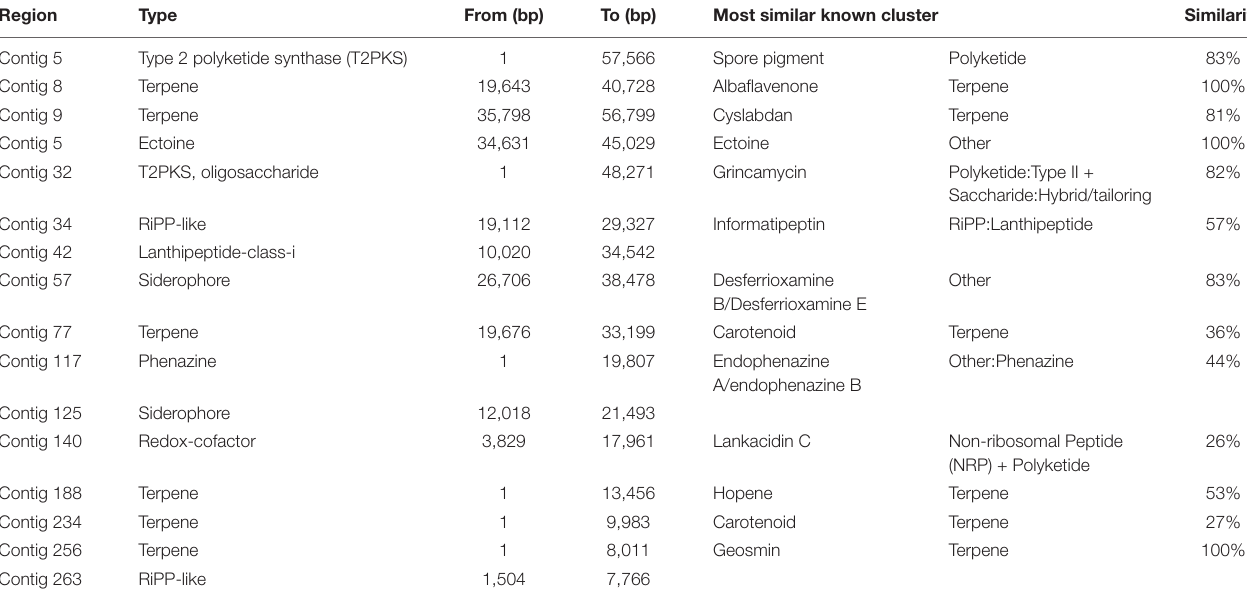
TABLE 1 | Streptomyces sp. AC04842 secondary metabolite biosynthetic gene clusters (BGCs) were predicted using antiSMASH 6.0 server (antiSMASH bacterial version with strict detection).